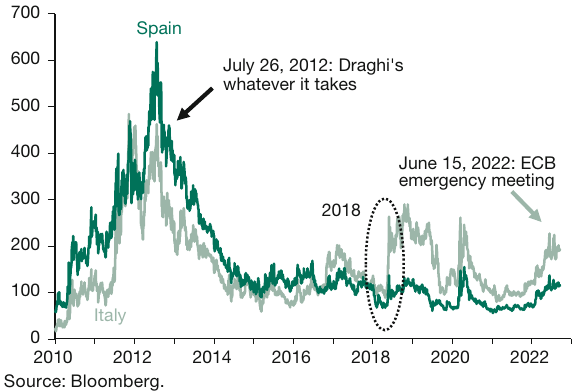
Figure 2 Standard deviation of daily changes in spread on Italian 10-year BTPs over German Bunds 20 day rolling